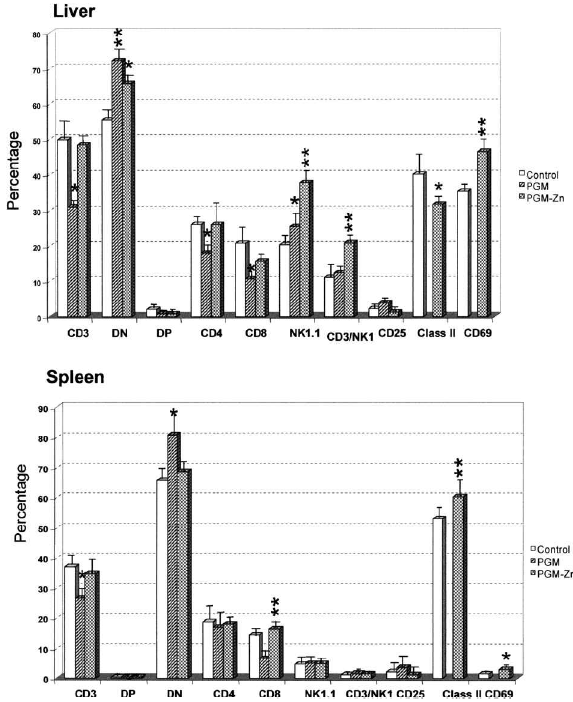
FIG. 1. Phenotypic profiles of hepatic and splenic MNLC obtained from C57BL/6 mice pretreated over 6 days with three doses of PGM-Zn, PGM (10mg/kg i.p.) or with saline solution ( n = 7). Mean ± standard errors are presented. * p < 0.05, ** p <